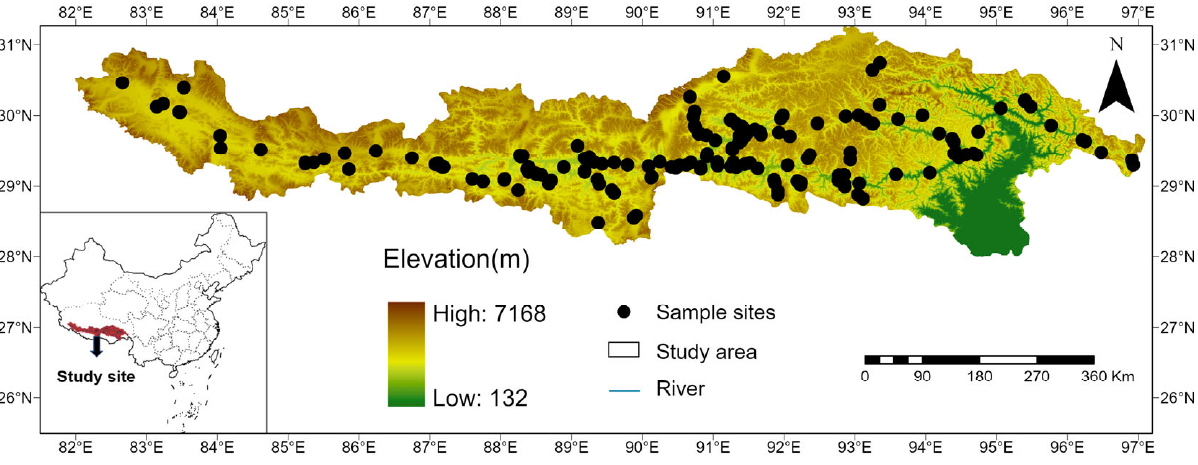
Figure 2. Distribution of soil sampling sites in the YTRB.